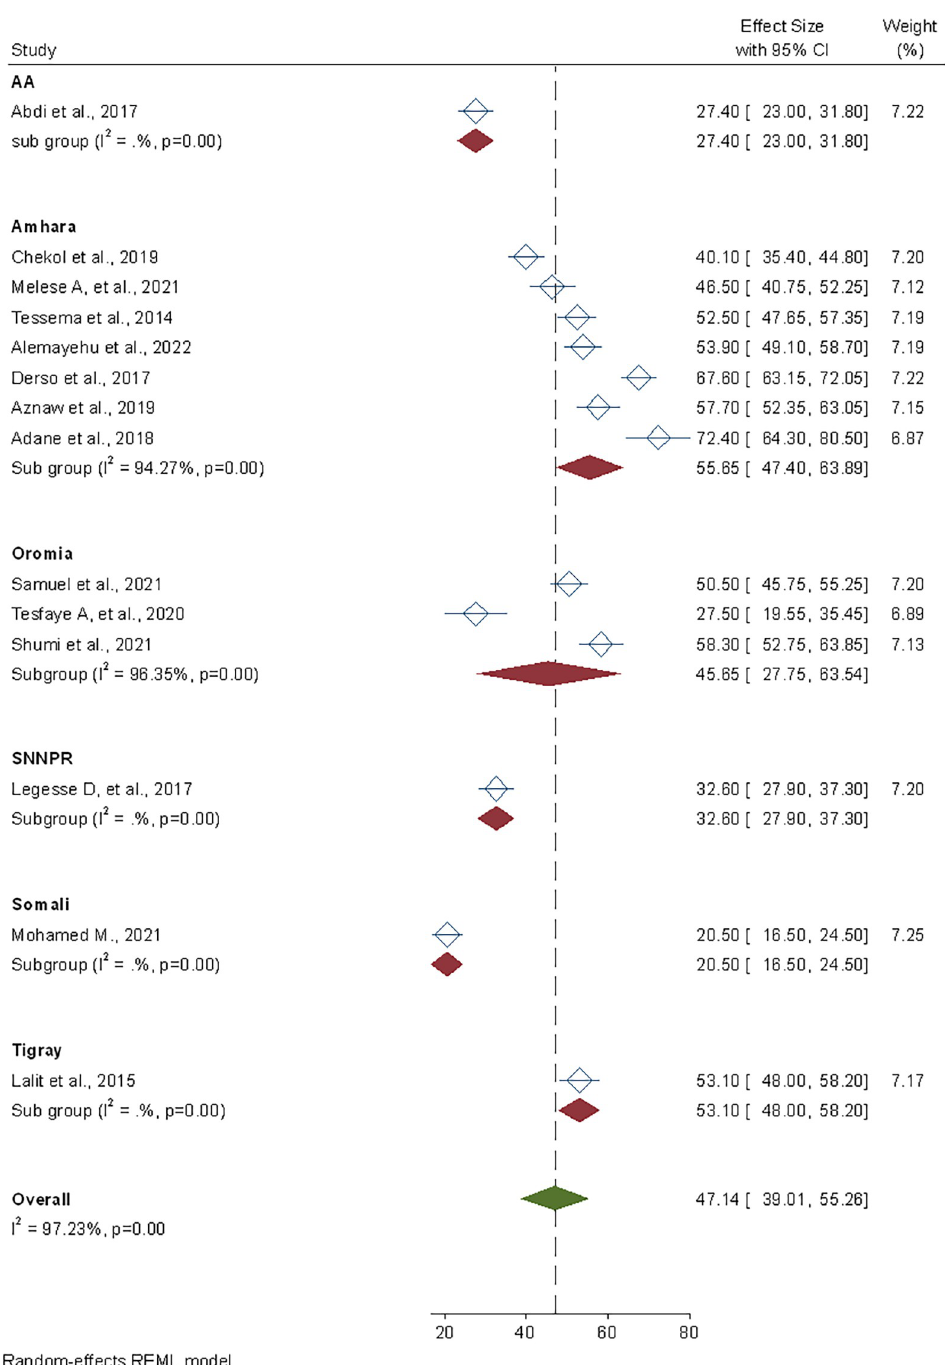
Fig 4. Sub-group pooled prevalence estimate of safe food handling practices by region among food handlers in foodservice establishments of Ethiopia, 2022.